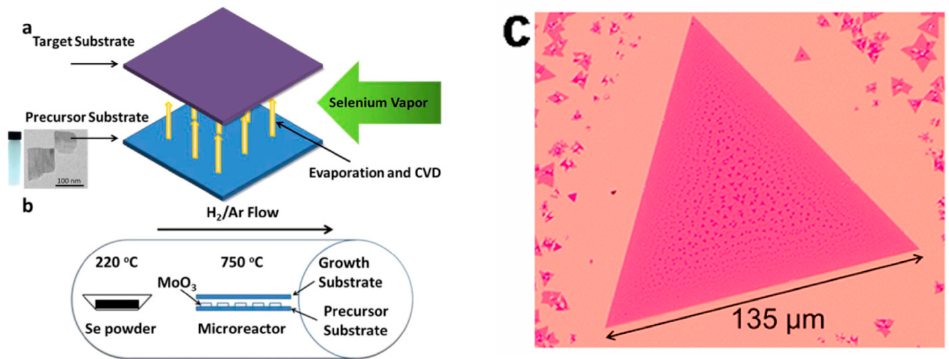
Figure 10. ( a ) Schematic of CVD process between the seed and target substrates, where selenium reacts with MoO 3 nanosheets to form MoSe 2 layers on the top substrate; ( b ) schematic of furnace setup; and ( c ) typical optical images of monolayer triangles, with some small bi-layered domains in darker color. ( a , b ) Reprinted with permission from [85]. Copyright (2015) Wiley-VCH Verlag GmbH. ( c ) Reprinted with permission from [86]. Copyright (2014) American Chemical Society: Washington, DC, USA.